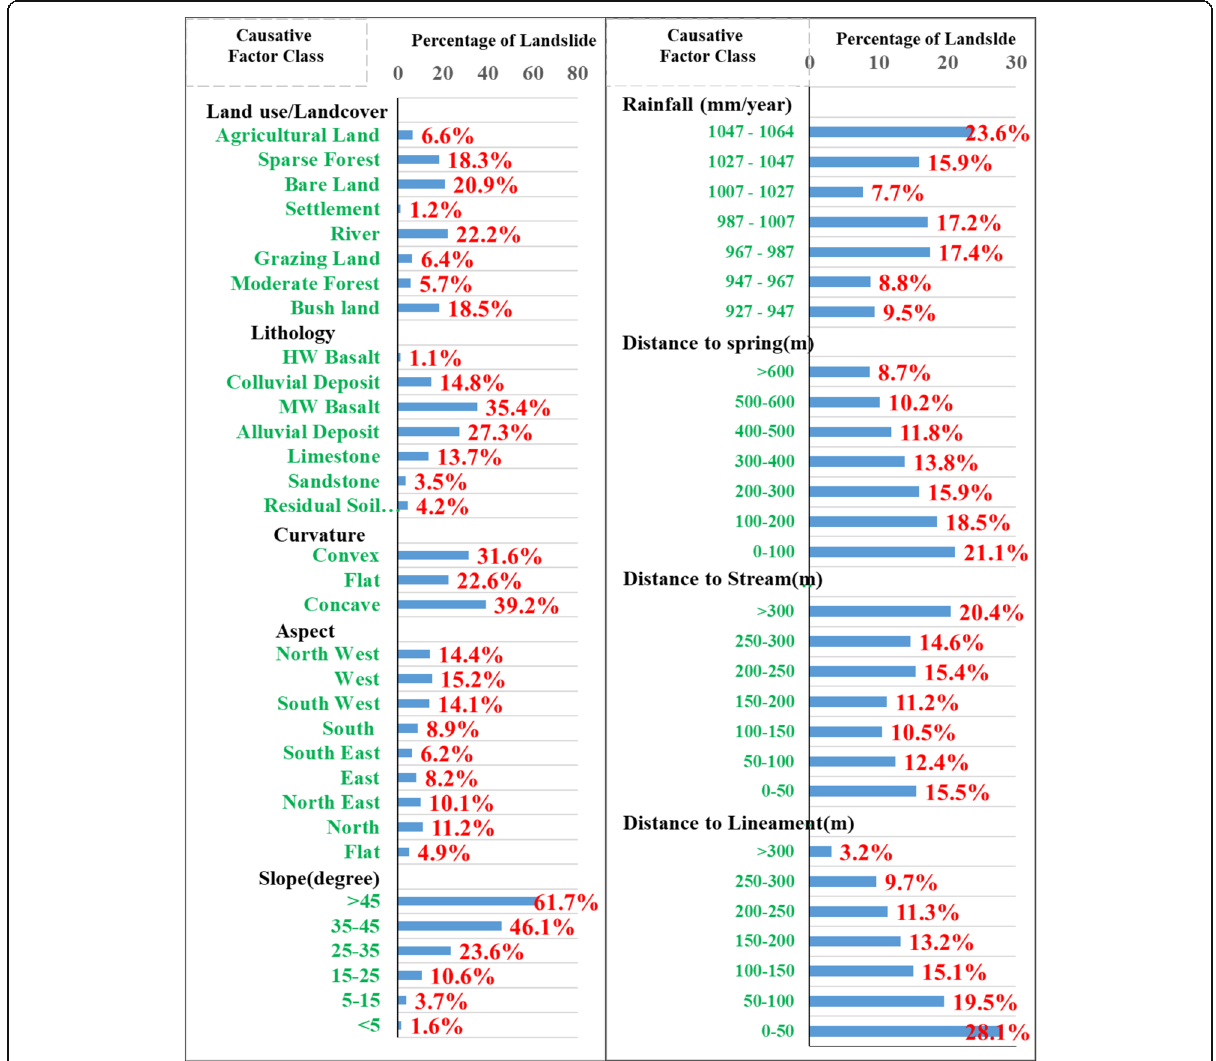
Fig. 7 Percentage of landslide occurrence in each factor class of the landslide causative factors. Note: HW Basalt = Highly Weathered Basalt and MW Basalt = Moderately Weathered